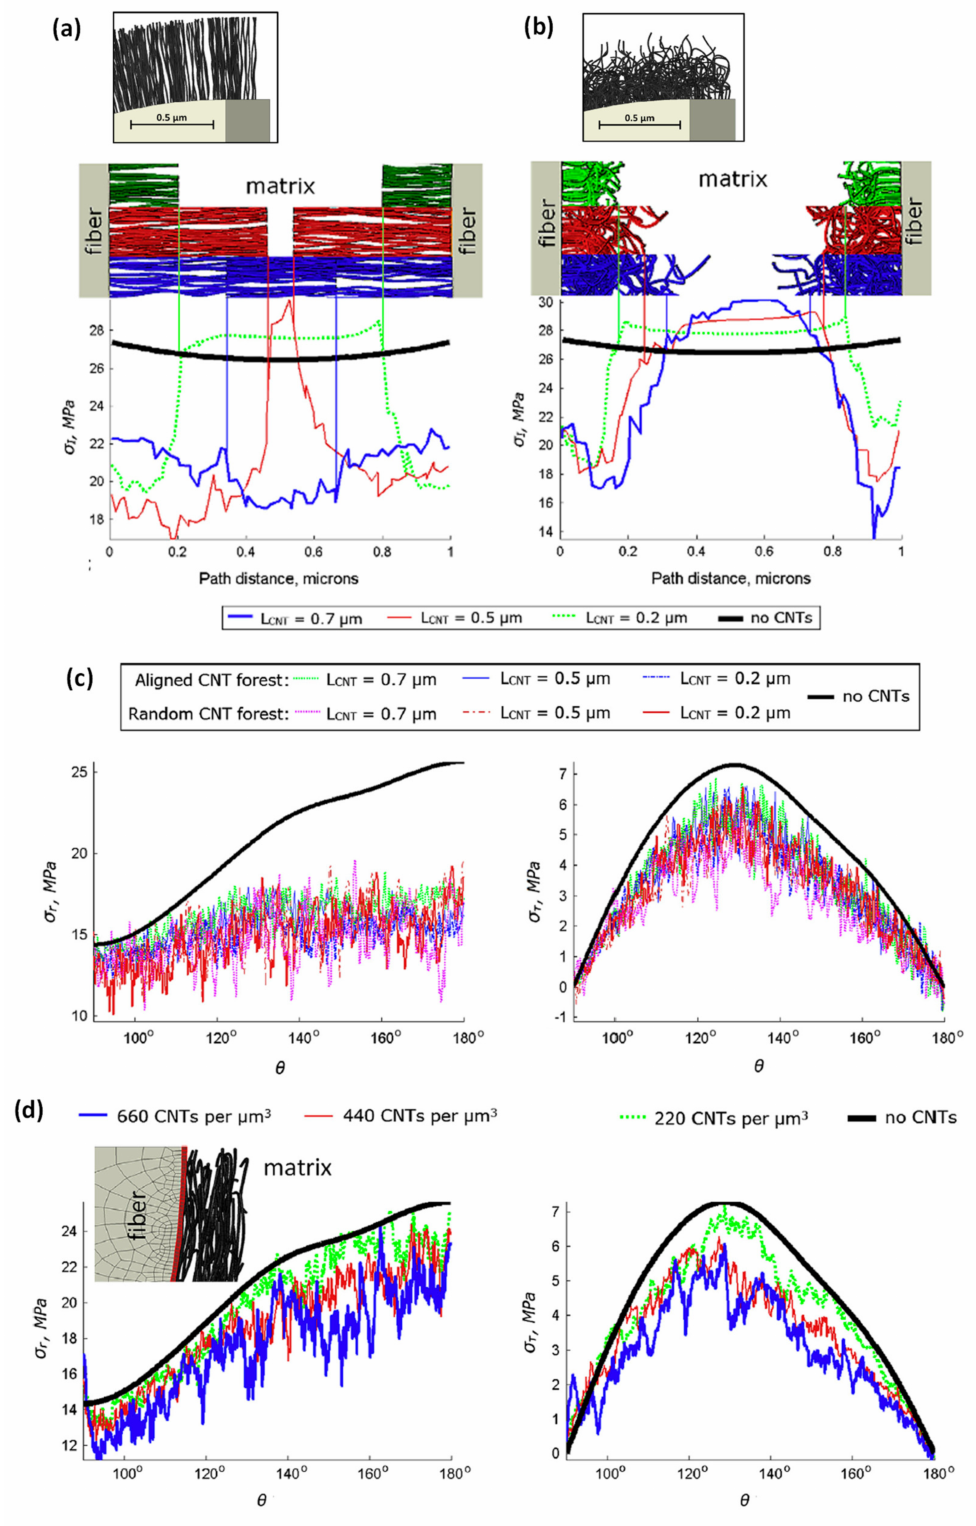
Figure 8. The maximum principal stress σ I in the matrix along the shortest path between the fibres for ( a ) aligned and ( b ) random CNTs forests; ( c ) the effect of CNT grafting on normal interface stress σ r and shear interface stress σ τ ; ( d ) the effect of CNTs in the fibre coating on normal stress σ r and shear stress σ τ at the interface (reprinted with permission from Romanov et al., 2015